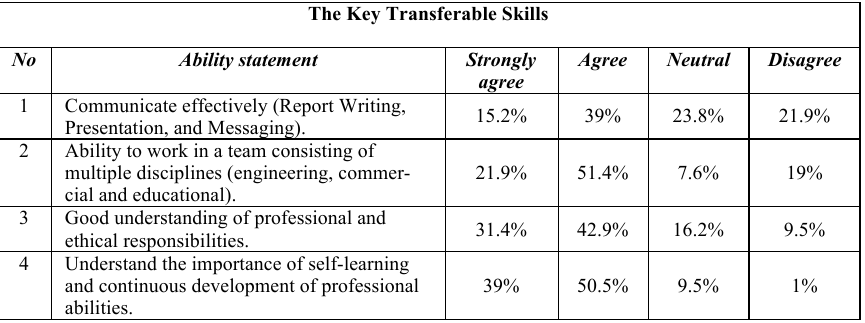
Table 4. Graduates feedback on The Key Transferable Skills learning outcomes The Key Transferable